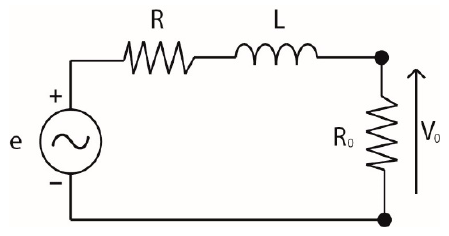
Figure 2. Equivalent circuit of the ILS.